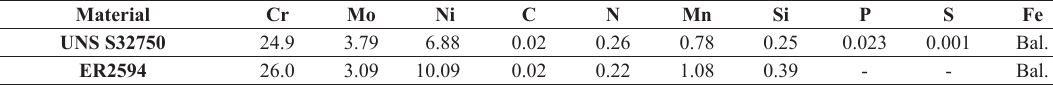
Table 1. Chemical composition of the super duplex stainless steel UNS S32750 and filler wire ER2594 (wt. %). Material